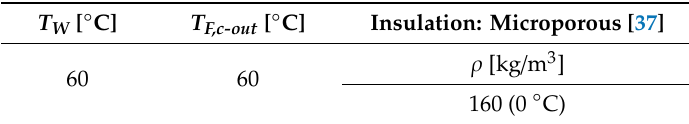
Table 4. Thermal insulation—specifications and selected